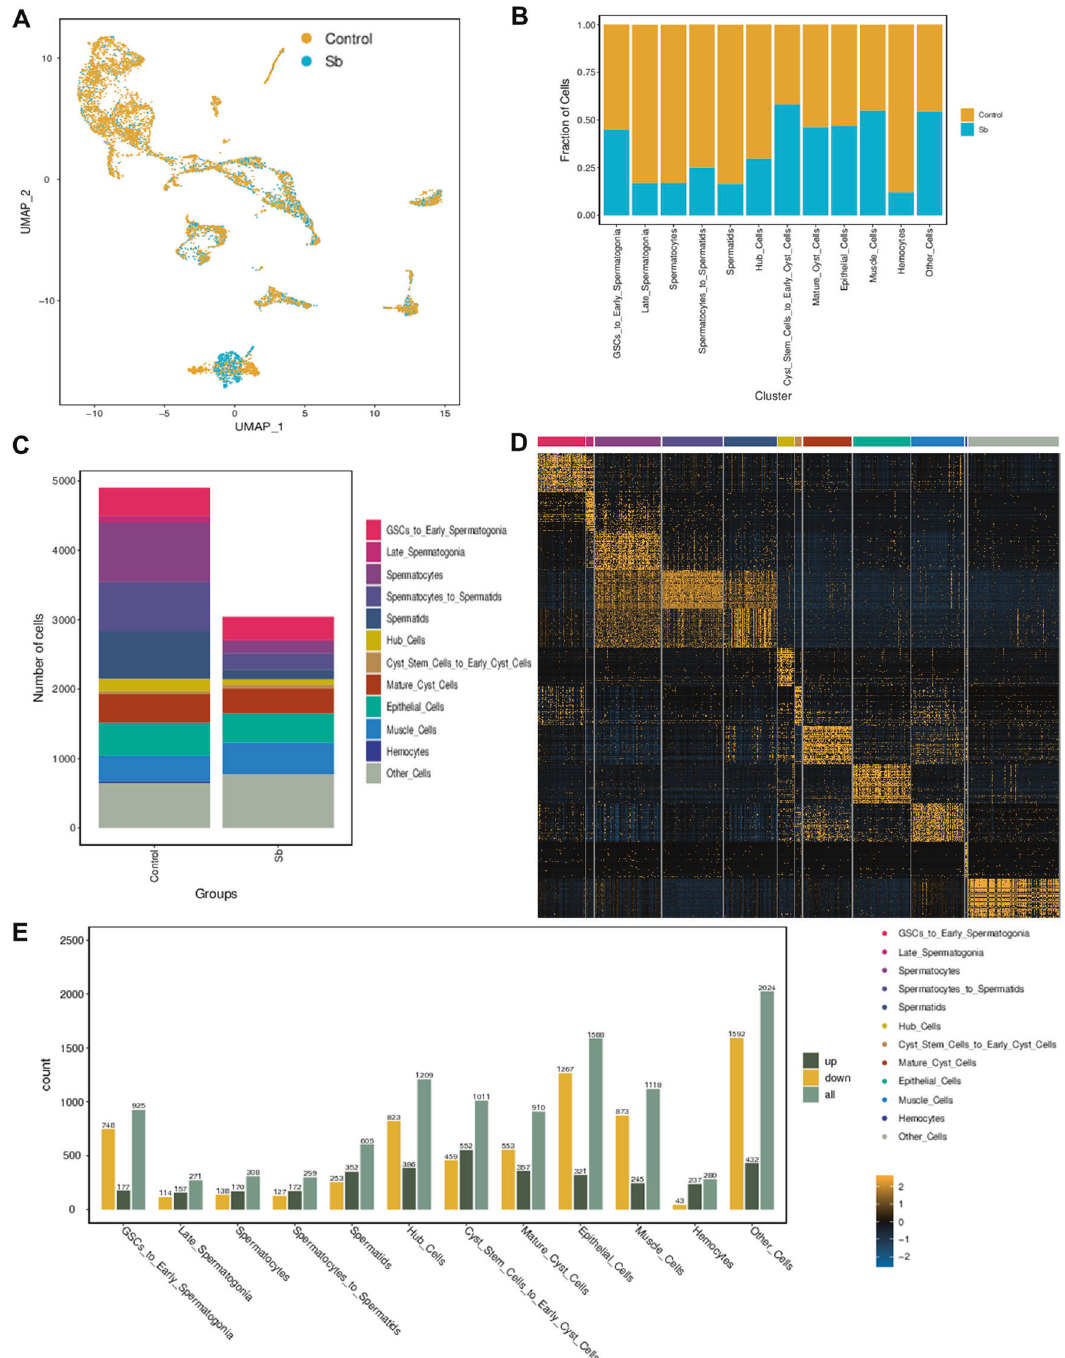
Fig. 3 Features of testicular cell populations in Drosophila . A UMAP visualization of testicular cells in each group. B Fraction of testicular cells in different cell clusters of control and Sb groups. C Cellular component analysis in control and Sb groups. D The heatmap of the most abundantly expressed genes in different cell clusters. E Analysis of DEGs in different cell